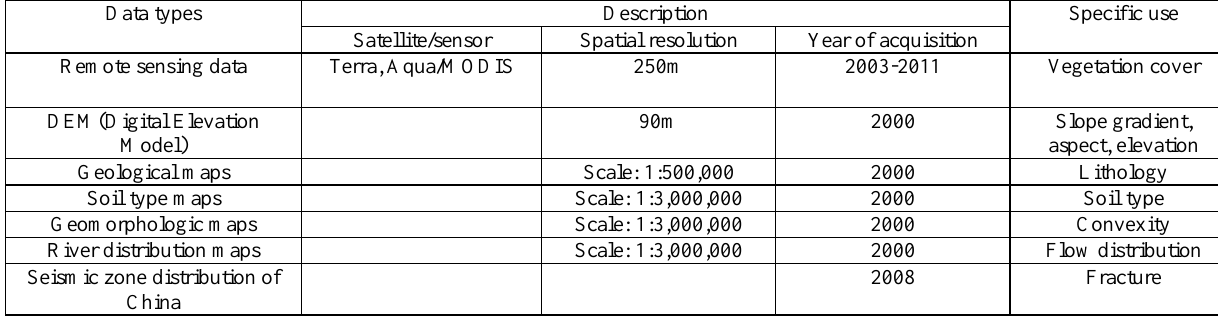
Table 1. Data sources and specific use.